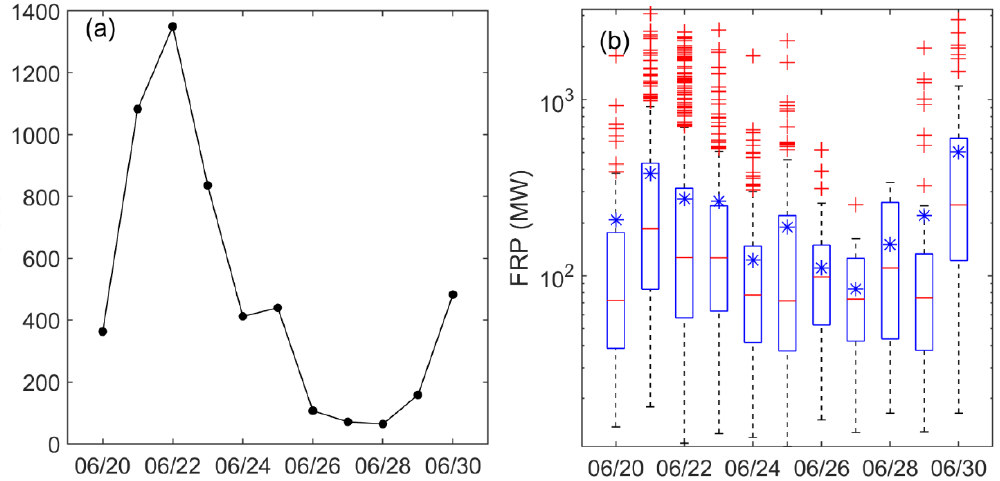
Figure 2. Daily fire counts ( a ) and fire radiative power (FRP) ( b ) in Siberia, monitored by Aqua MODIS from 20 June to 30 June 2017. The central bar in ( b ) is the median and the lower and upper limits are the first and third quartiles, respectively. The lines extending vertically from the box indicate the distribution spread, with the length being 1.5 times the difference between the first and third quartiles. Observations falling beyond the limits of those lines are indicated by plus symbols. The asterisk symbols represent geometric means.